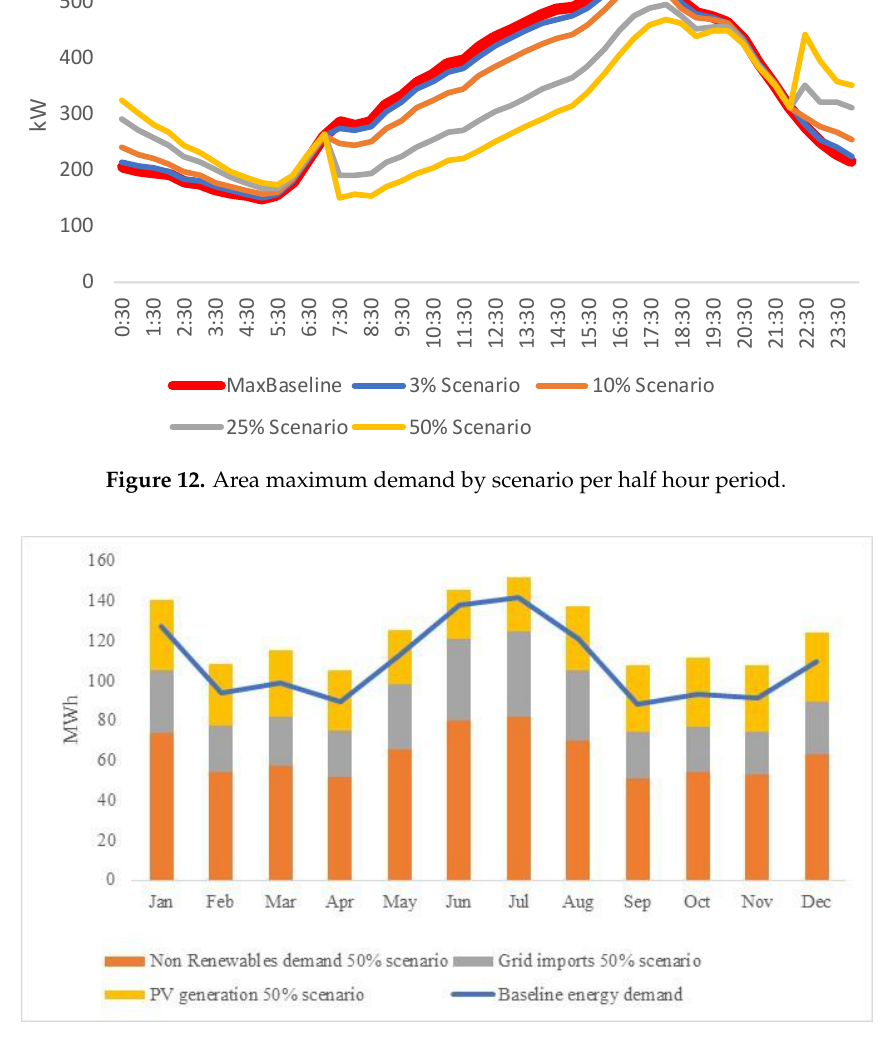
Figure 13. Net energy use, PV generation, and grid imports. 50% scenario.